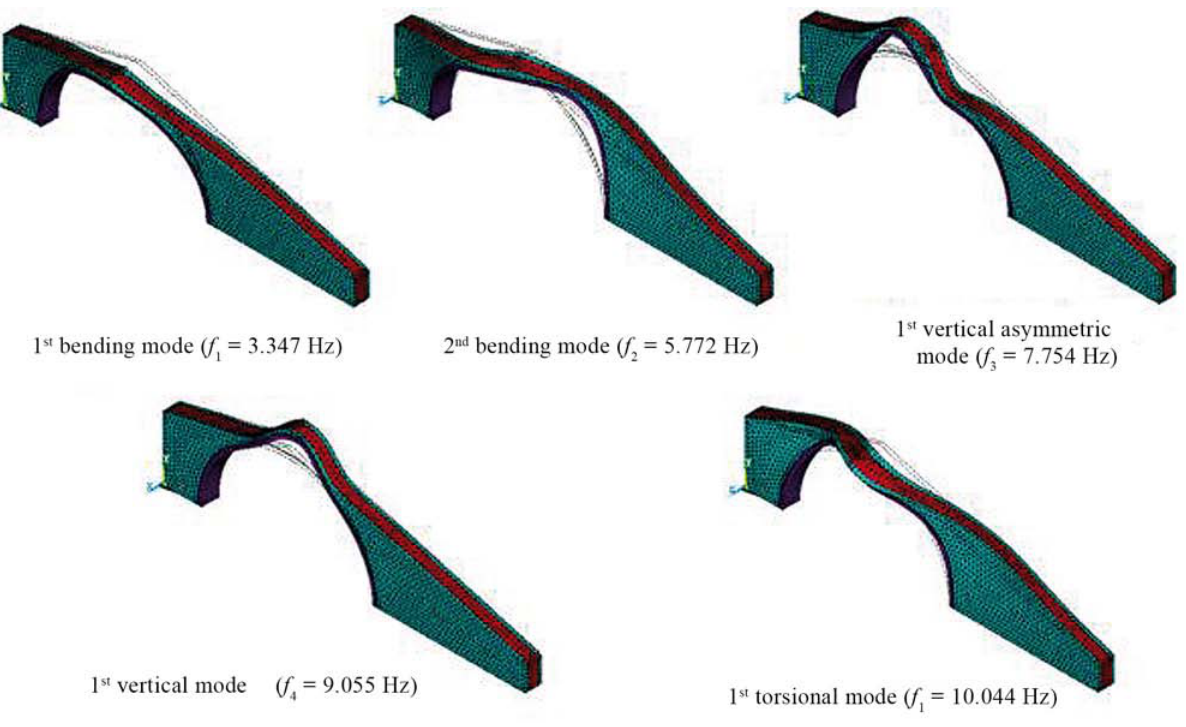
Fig. 5. Analytically identified first 5 mode shapes